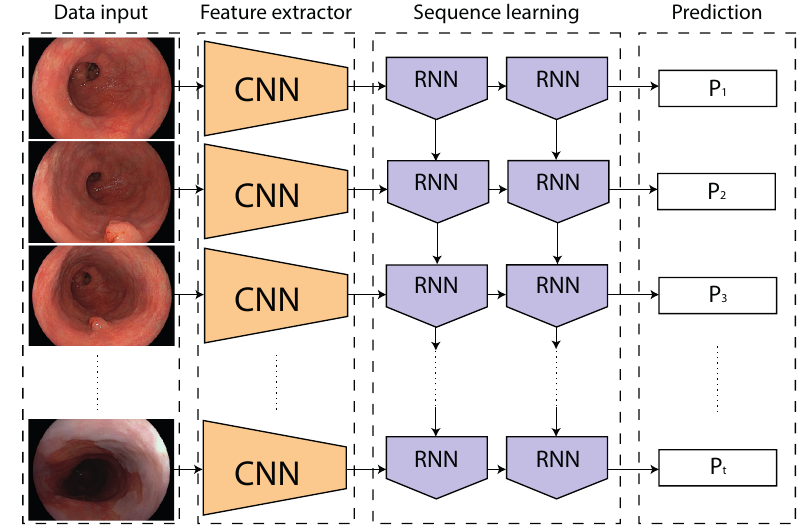
Figure 2. Data flow through the proposed model during training. Recurrent Neural Network (RNN) represents either Long Short-Term Memory (LSTM) or Gated Recurrent Unit (GRU)